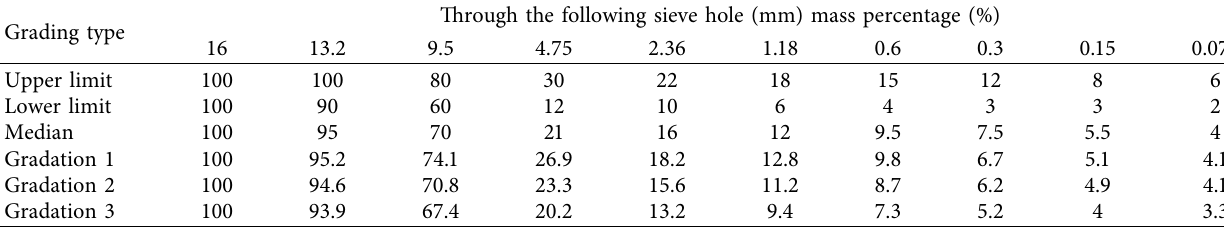
Table 6: Mineral aggregate gradation of OGFC-13 asphalt